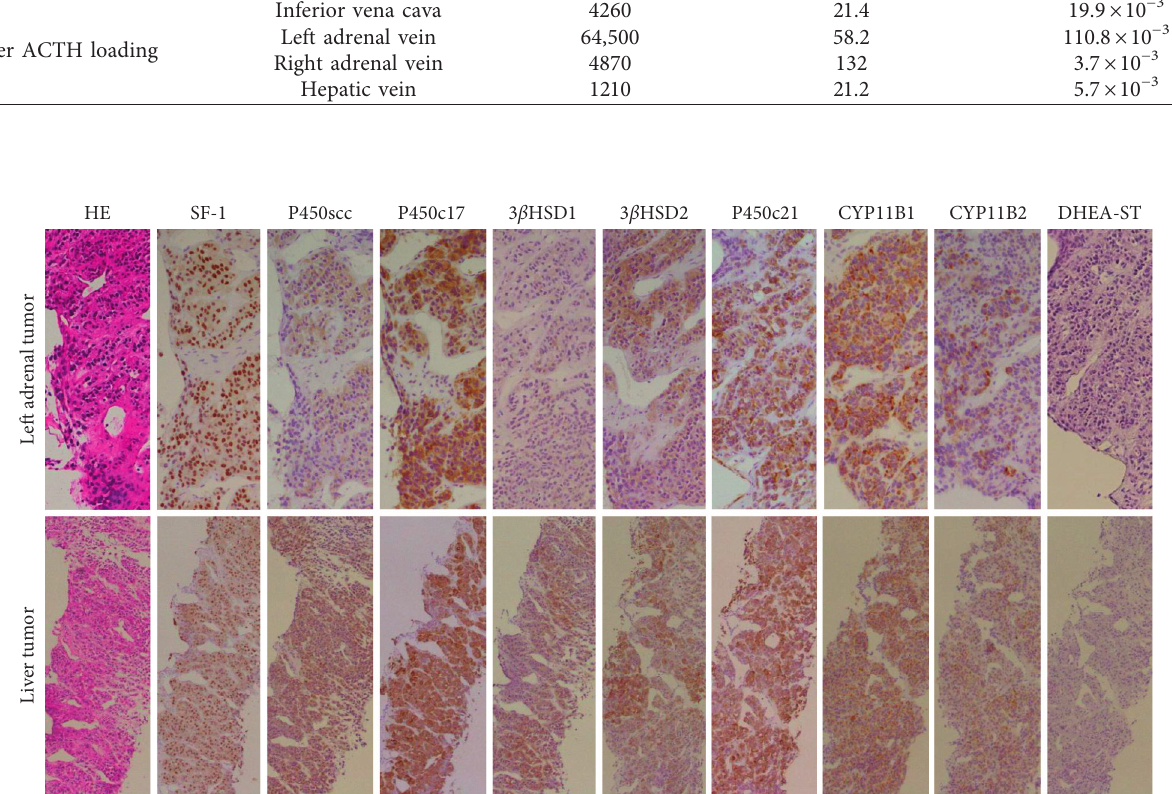
Figure 2: Results of histopathological and immunohistochemical investigation of left adrenal and liver biopsy specimens (magnification, × 200). Microscopic appearance (hematoxylin and eosin, HE, staining) showed eosinophilic tumor cell cytoplasm, nuclear atypia, diffuse architecture, and sinusoidal invasion. Immunohistochemical staining showed strong positive reactivity for SF-1, P450c17, 3 β HSD2, P450c21, CYP11B1, and CYP11B2 and partial positive reactivity for P450scc and 3 β HSD1 in both the left adrenal tumor (upper panel) and the liver tumor (lower panel). The DHEA-ST test result was negative for both